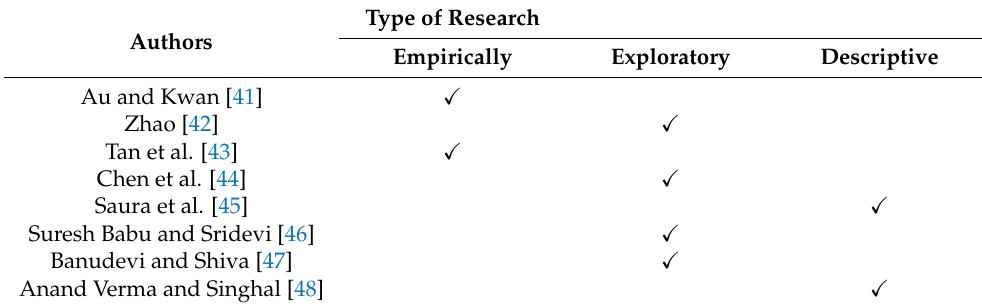
Table 2. Type of research applied in previous